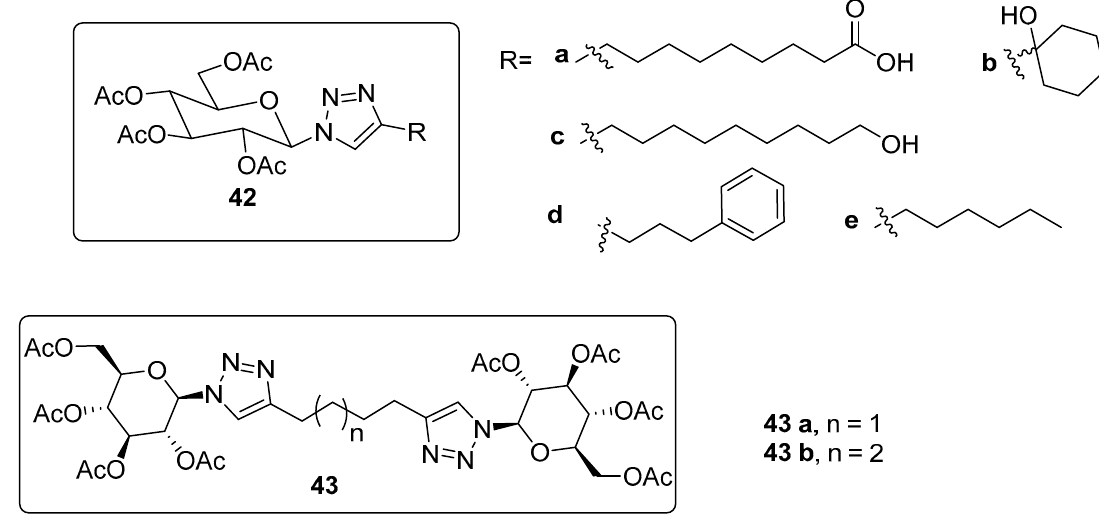
Figure 30. Structures of glucosyl triazole-based gelators [39].